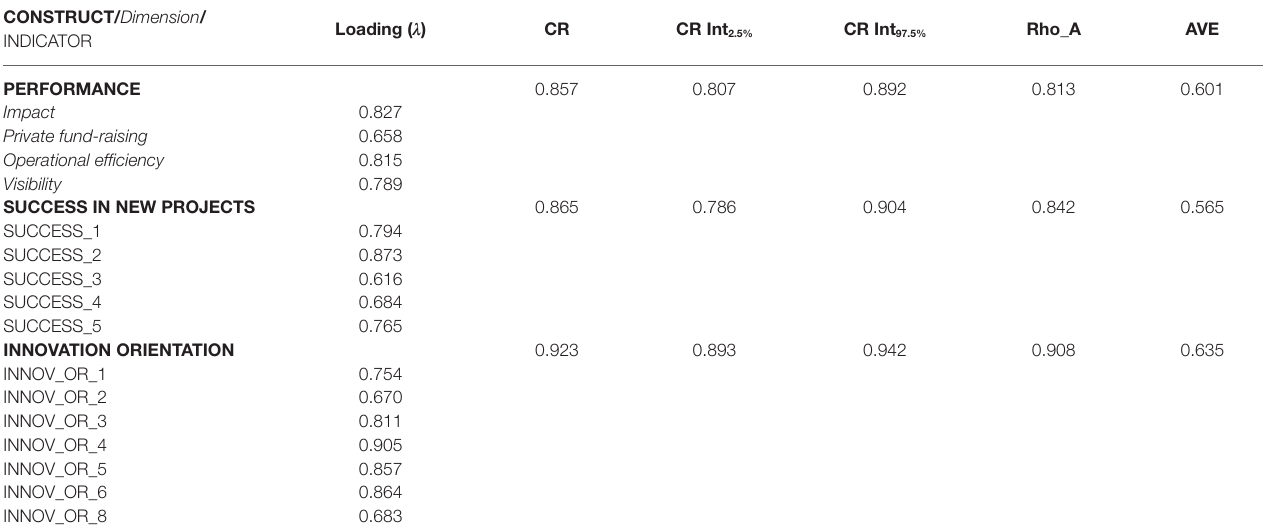
TABLE 7 | Validation indicators of the second-order model’s measurement instruments.